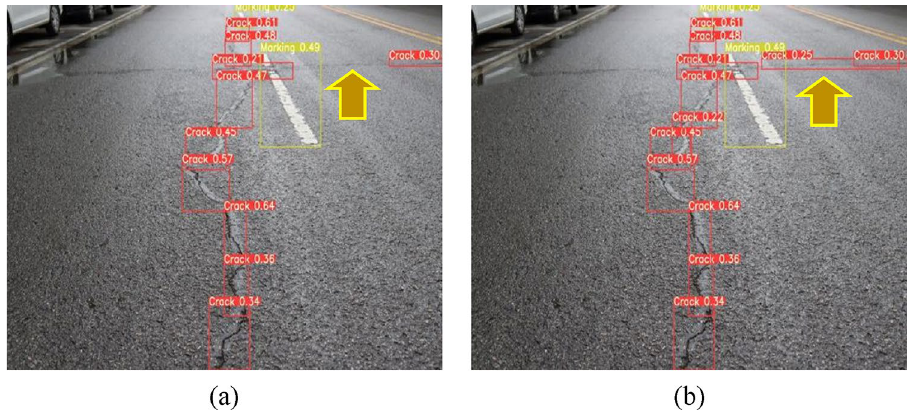
Figure 17. Impact of confidence threshold on detection result. ( a ) Threshold is not appropriate ( b ) Threshold is appropriate.